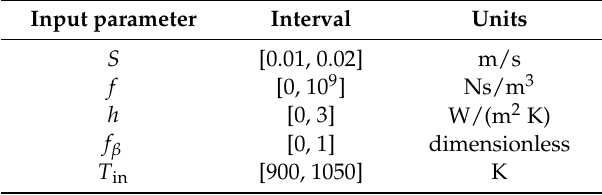
Table 6. Input parameter